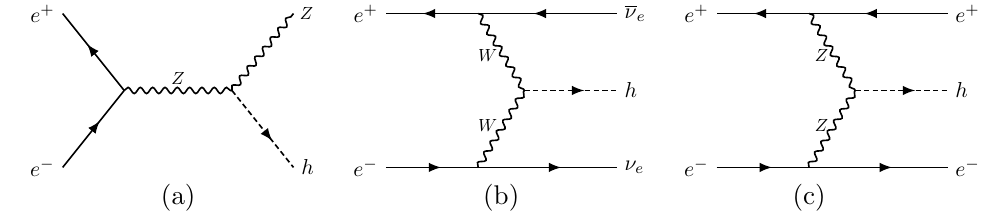
Figure 7 . Feynman diagrams for Higgs production via HS (a) and VBF (b, c) at e + e